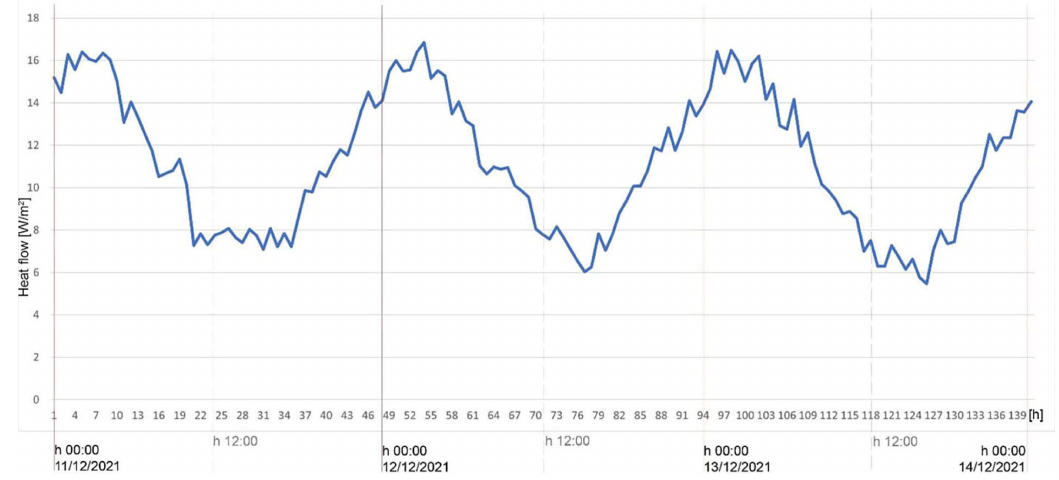
Figure 15. Tuff perimeter wall heat flow diagram as a function of time: ante